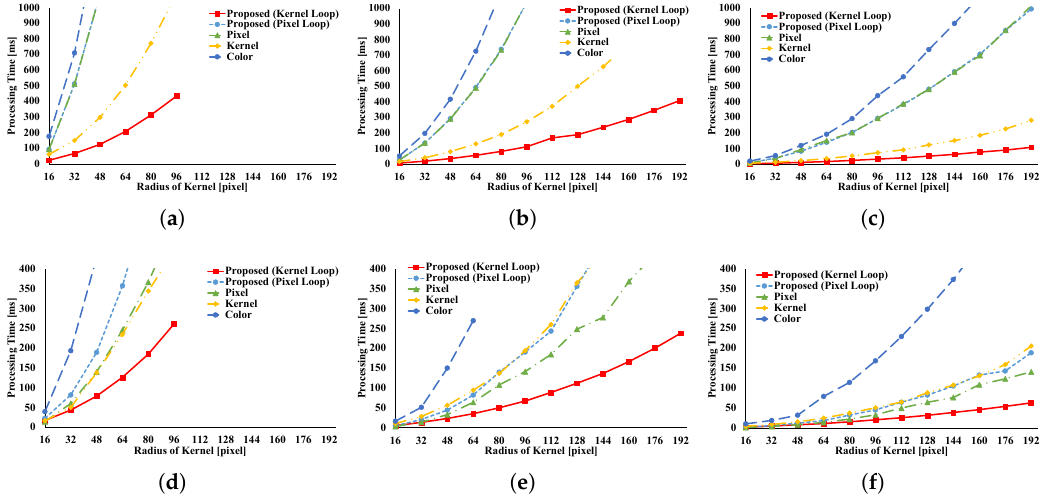
Figure 12. Processing time for adaptive Gaussian filtering (AGF) with respect to the kernel radius of FIR filtering. ( a ) Full sample in weight computation; ( b ) 1/4 subsample in weight computation; ( c ) 1/16 subsample in weight computation; ( d ) Full sample in LUT; ( e ) 1/4 subsample in LUT; ( f ) 1/16 subsample in LUT. Note that arbitrary kernel loop unrolling is used instead of kernel loop unrolling in the kernel-subsampling conditions.